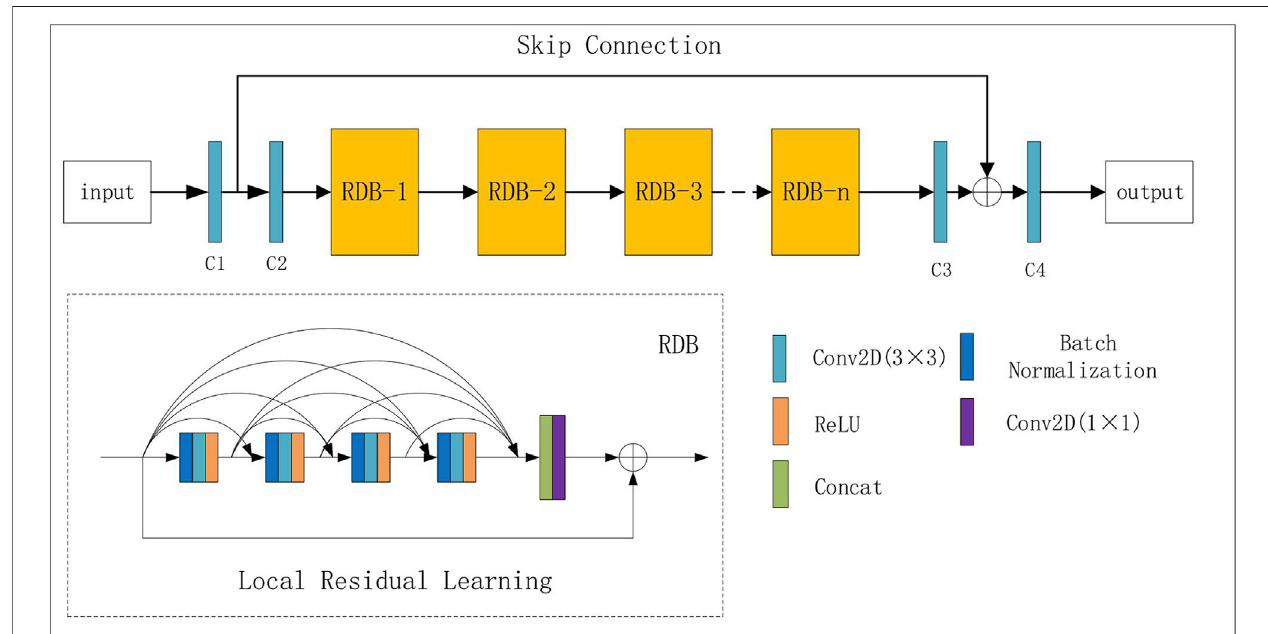
FIGURE 1 | The DnRDB model